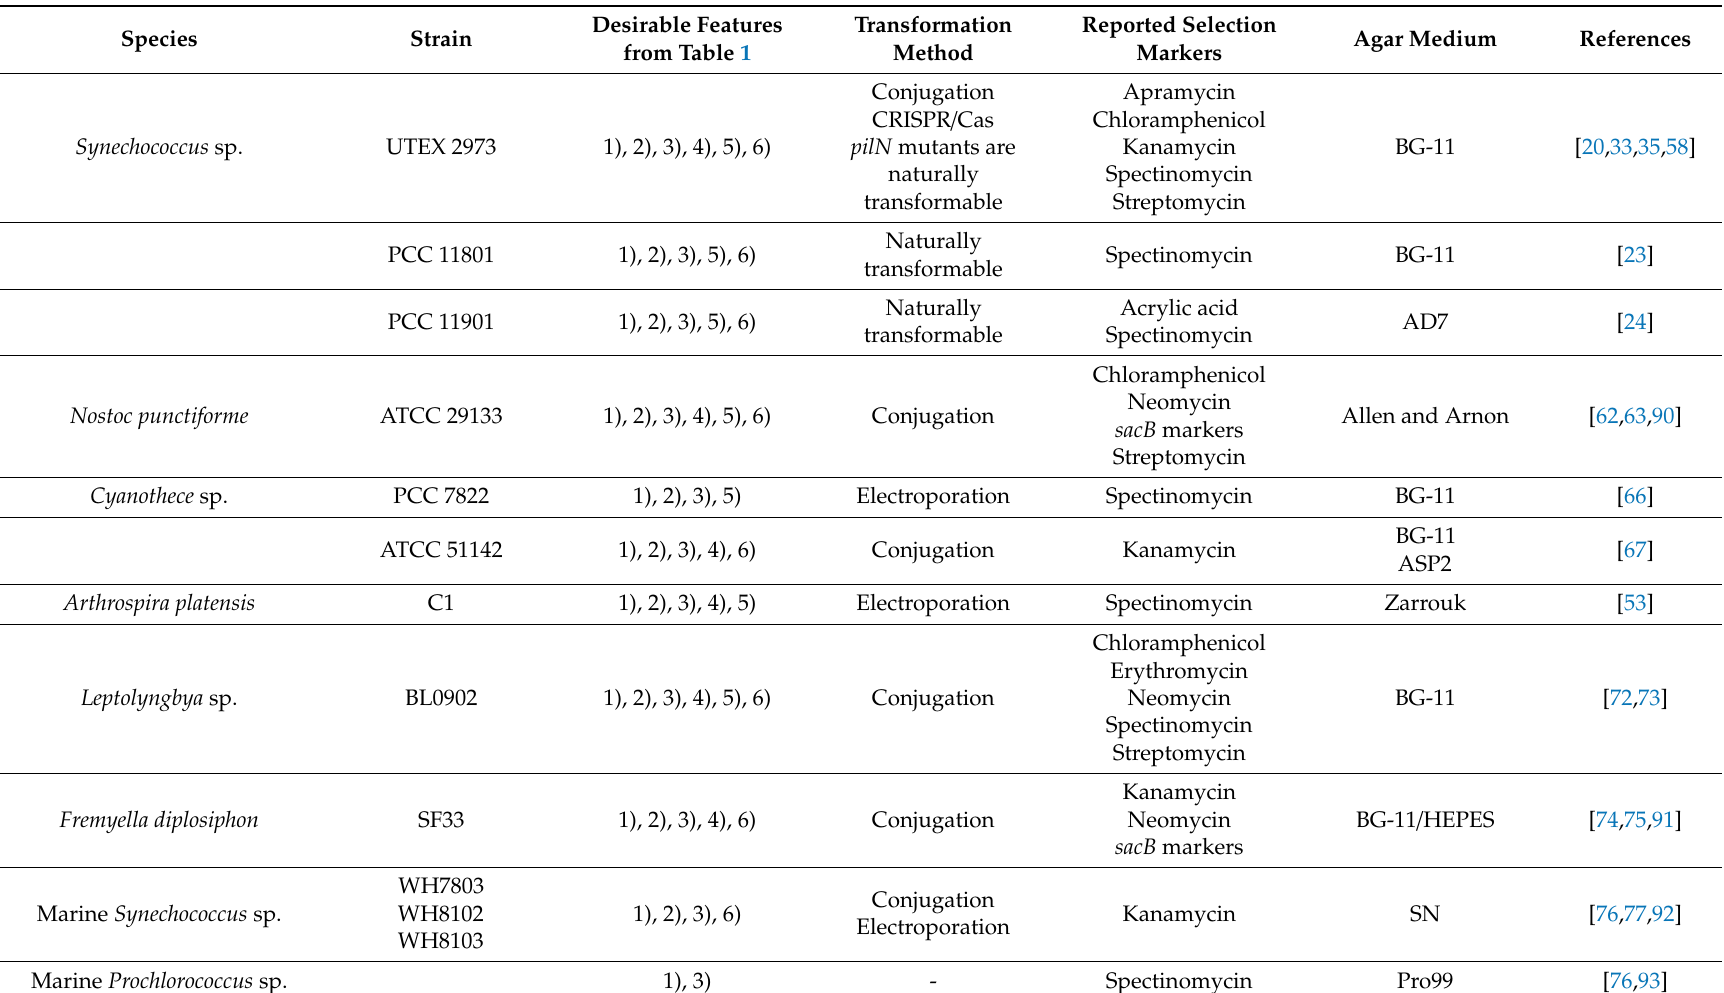
Table 2. Summary of genetic manipulations carried out in model and non-model cyanobacterial species discussed in Section 2. Species Strain from Table